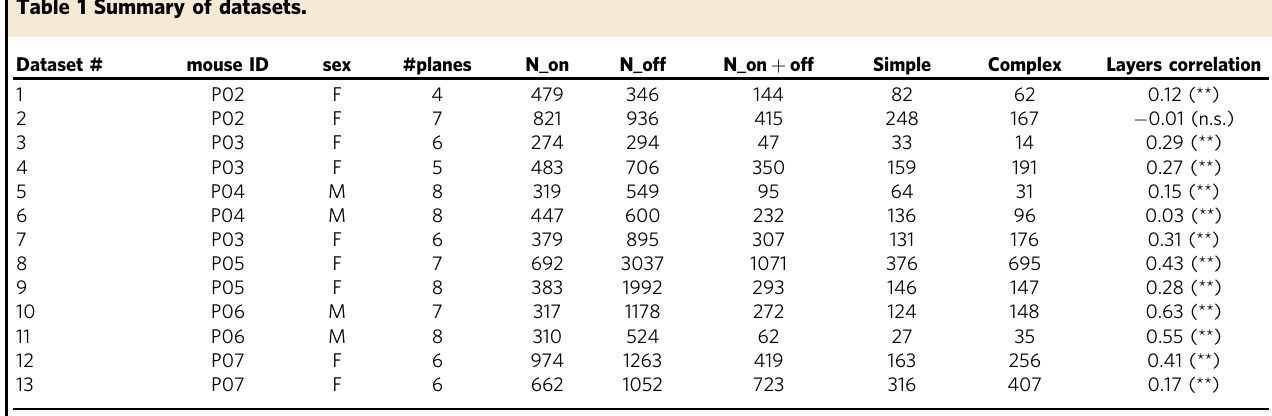
Table 1 Summary of